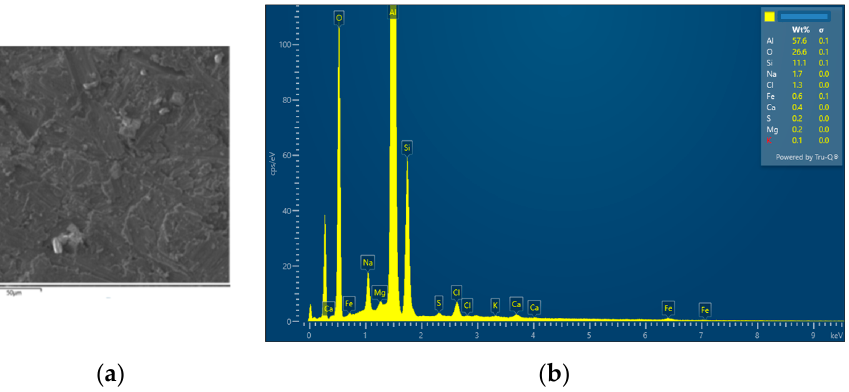
Figure 20. EDX analysis and its evaluation with respect to the local chemical composition: ( a ) chemical composition of the AlSi12 alloy used; ( b ) sample SAM7.